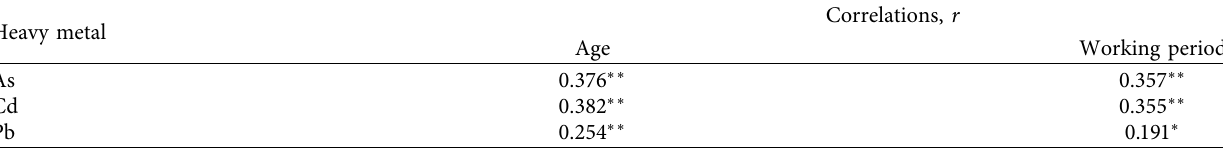
Table 6: Correlation between concentrations of As, Cd, and Pb in fingernails of Libyan farmers and their age and working period. Heavy metal